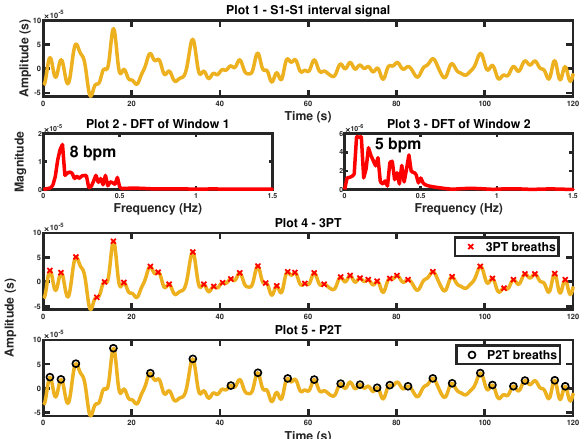
Figure 5. DFT and TD analysis of the S1-S1 interval signal on b001: Plot 1 shows the S1-S1 interval signal for subject b001. Plots 2 and 3 represent the DFT analysis. Plot 4 shows the breaths obtained from 3PT method as red crosses. Plot 5 shows the breaths obtained from P2T method as black